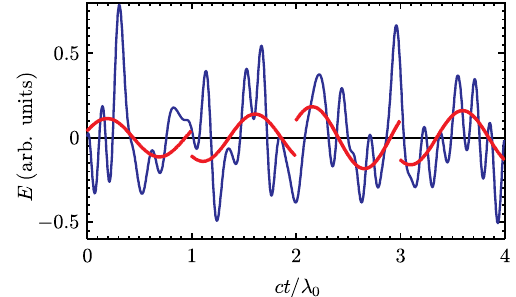
FIG. 1. A representative example of binning a broadband field (blue curve) to a grid of spacing (cid:1) 0 for use in a SVEA code. The discontinuous red curve sinusoids represent the phase and am- plitude obtained for the fundamental frequency component within each two simulation codes, the same process is applied to AURORA radiation output.